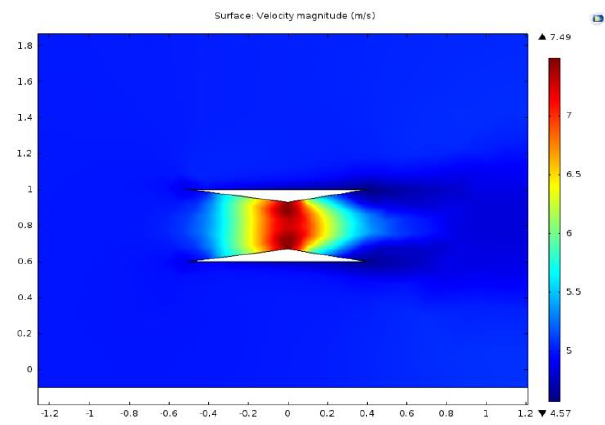
Figure 6. Air flow rate plotting area